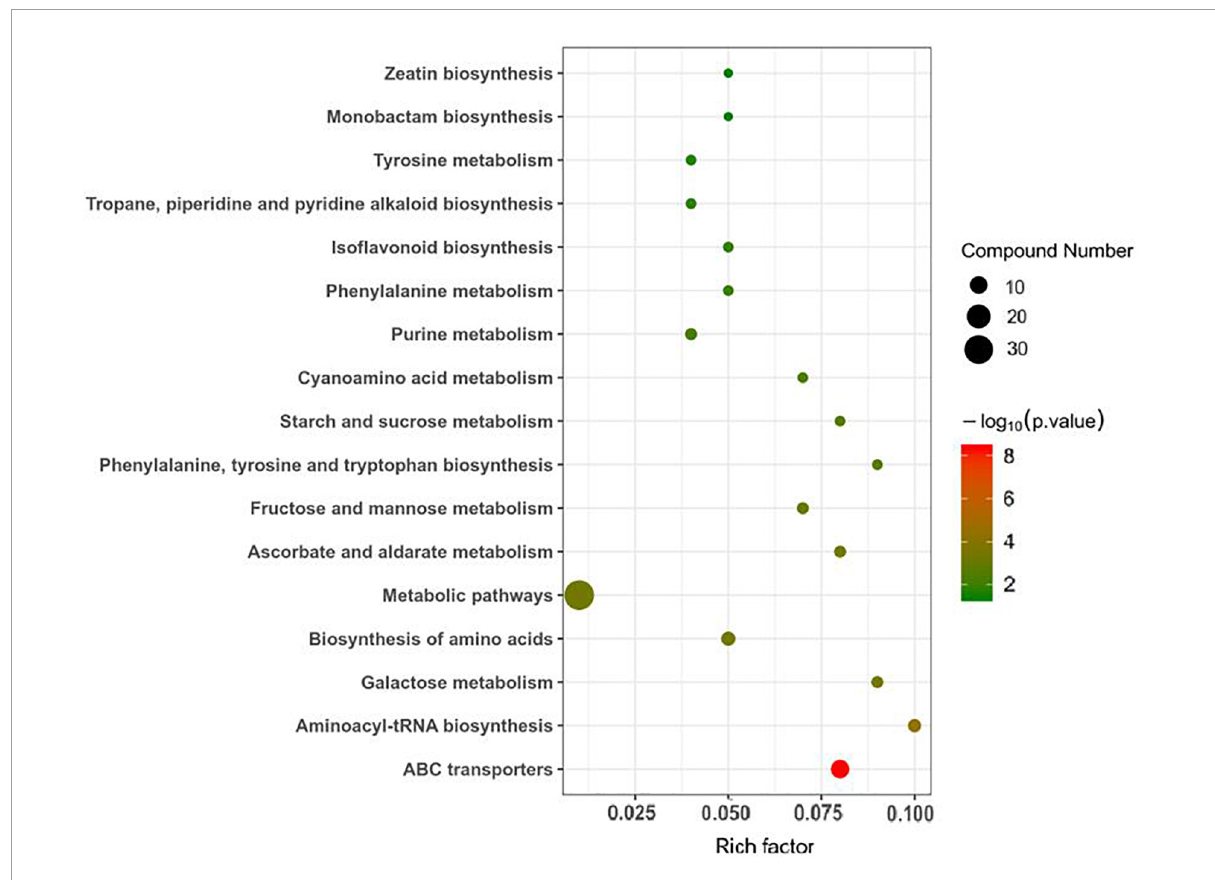
FIGURE3 Metabolic pathways enriched with